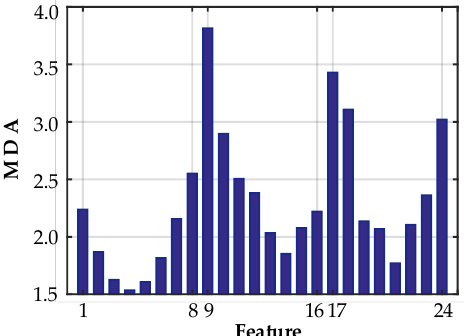
Figure 7. Calculated MDAs with respect to the temperature, humidity, and atmospheric pressure. Notes: Features 1–8 represent the temperatures of the periods 4–11 × 15 min before the current period, respectively; features 9–16 represent the humidities of the periods 4–11 × 15 min before the current period, respectively; and features 17–24 represent the atmospheric pressures of the periods 4–11 × 15 min before the current period, respectively.